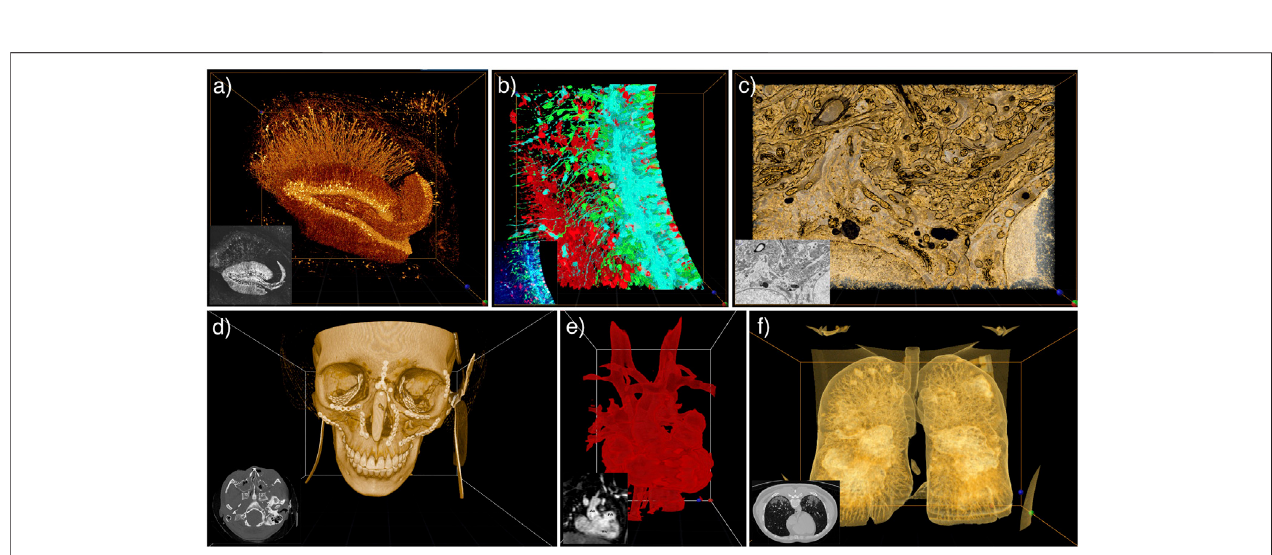
FIGURE2| DIVAapplicationexamplesonthedesktopinterfacewiththeircorrespondingrawimageinthebottomleftcorner. (A – C) TIFFimagestacksof (A) Mouse hippocampus imaged by two-photon serial endblock imaging (SEBI, Thy-1-GFP mouse) (Sun et al., 2013). (B) Mouse embryonic brain slices from spinning